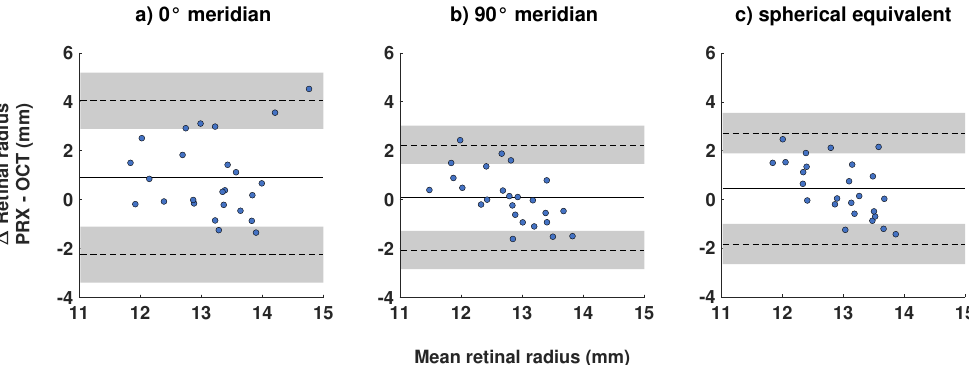
Figure 3. Bland–Altman plots for the comparison between PRX- and OCT-based retinal radii of curvature ( n =25) for the ( a ) 0 ◦ refractive meridian, ( b ) 90 ◦ refractive meridian, and ( c ) spherical equivalent